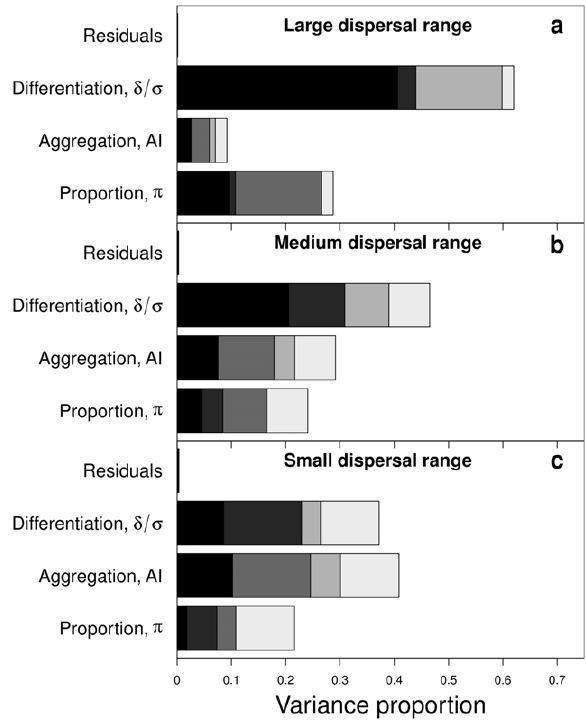
Figure 5. Sensitivity of the branching criterion given in Equation (4) to habitat differentiation ( d = s ), habitat aggrega- tion index ( AI ) and habitat proportion ( p ). a: large dispersal range ( m s ~ 75% ); b: medium dispersal range ( m s ~ 37 : 5% ) and c: small dispersal range ( m s ~ 15% ). Black bar: main effect ( SI (1) darkest to the lightest grey bars: interaction d = s | AI and p | AI ; interaction AI | d = s and p | d = s ; interaction d = s | p and AI | p ; and triple interaction. The total bar length indicates the total effect ( TSI v